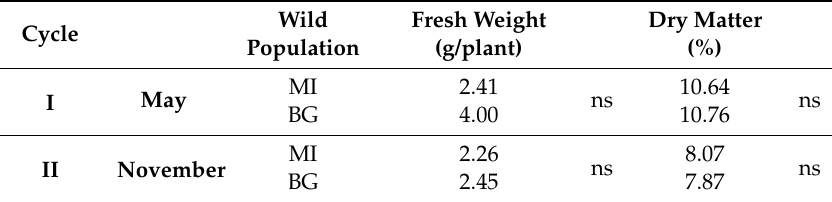
Table 1. Fresh weight and % of dry matter in MI and BG hedge mustard wild populations at the baby leaf stage after two production cycles. Data are expressed as means of five plants ( n = 5).